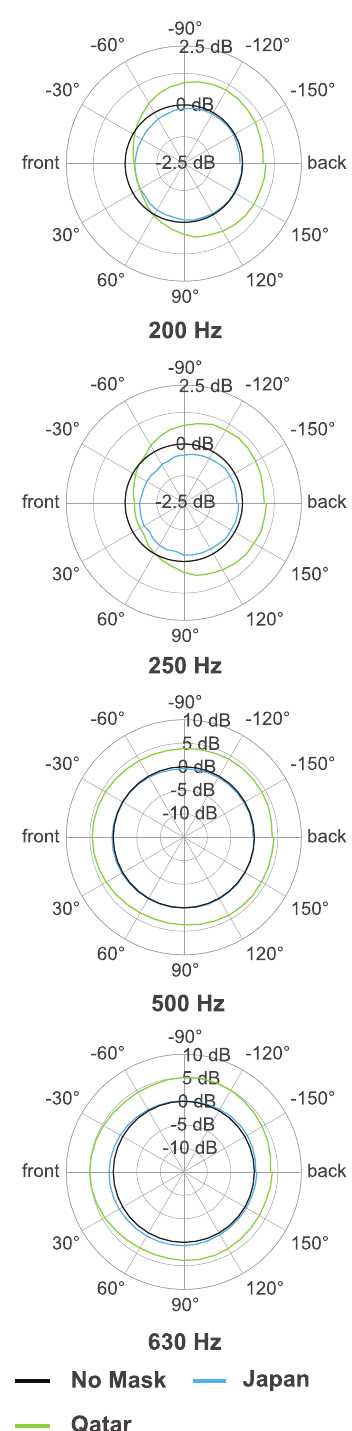
Figure 5. Polar plots of the sound radiation for the transparent masks Japan and Qatar normalized by the sound without (no) masks for speci fi c frequencies (200 Hz, 250 Hz, 500 Hz and 630 Hz). Front indicates the position of the KEMAR head with the mouth pointing at the microphone, back indicates the back of the head pointing towards the